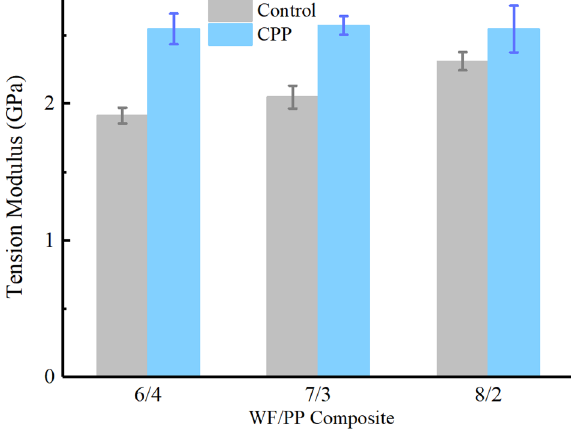
Figure 10. The tension modulus properties of the WF/PP composites.